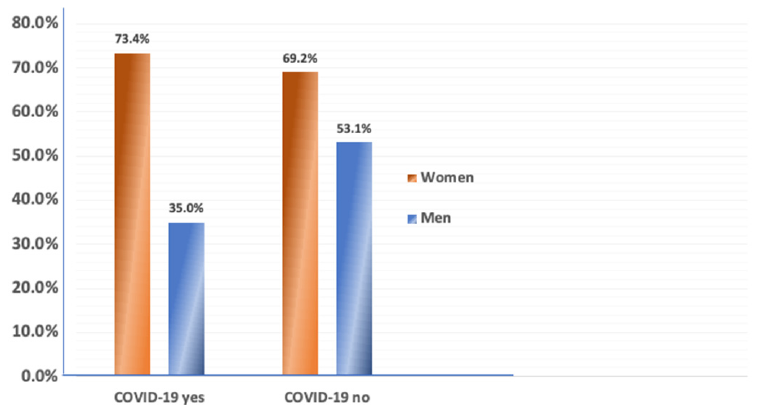
Figure 3. Prevalence (%) of osteosarcopenic adiposity (OSA) in women and men according to COVID-19 .